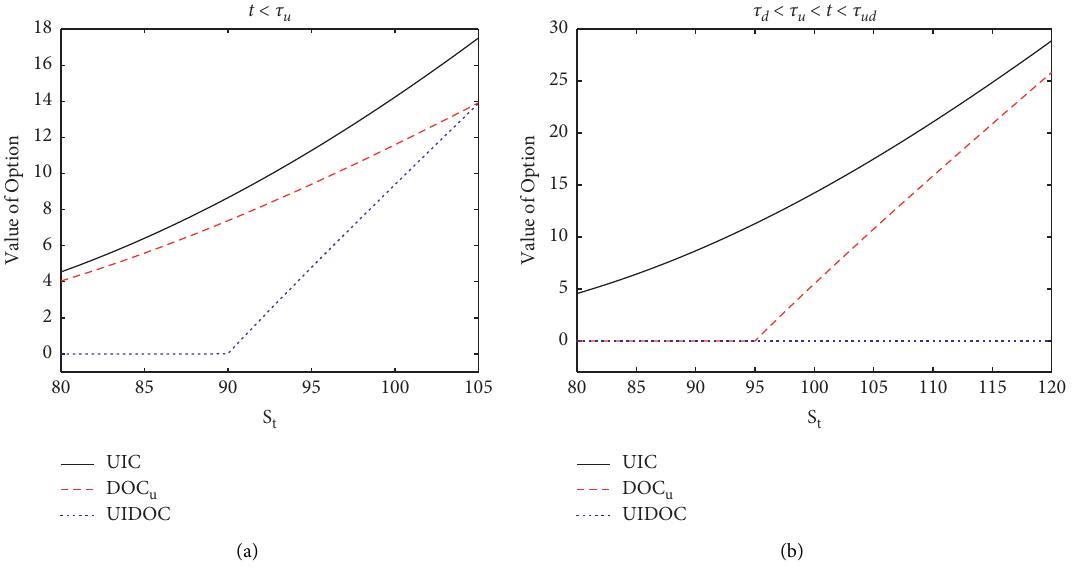
Figure 1: Comparison of UIC , DOC